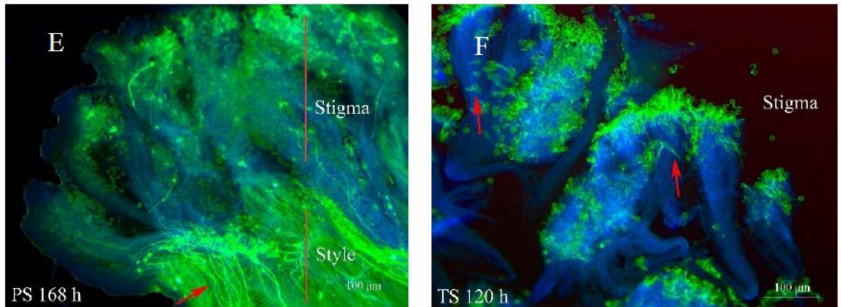
Figure 2. P. maximowiczii pollen germination and pollen tube growth after different pollination treatments. ( A ) In the pin cross-pollination (PT), pollen grains germinated and pollen tubes grew into the stigma at 4 h after pollination; ( B ) In the PT cross, pollen tubes entered the ovary at 96 h after pollination; ( C ) In the thrum cross-pollination (TP), pollen grains germinated and pollen tubes grew into the stigma at 8 h after pollination; ( D ) In the TP cross, pollen tubes entered the ovary at 48 h after pollination; ( E ) In the pin self-pollination (PS), a few pollen tubes entered the style at 168 h after pollination; ( F ) In the thrum self-pollination (TS), pollen grains germinated on the stigma at 120 h after pollination. Red arrows indicate pollen tubes. Red lines indicate various labeled sites, such as the stigma, style, and ovary.